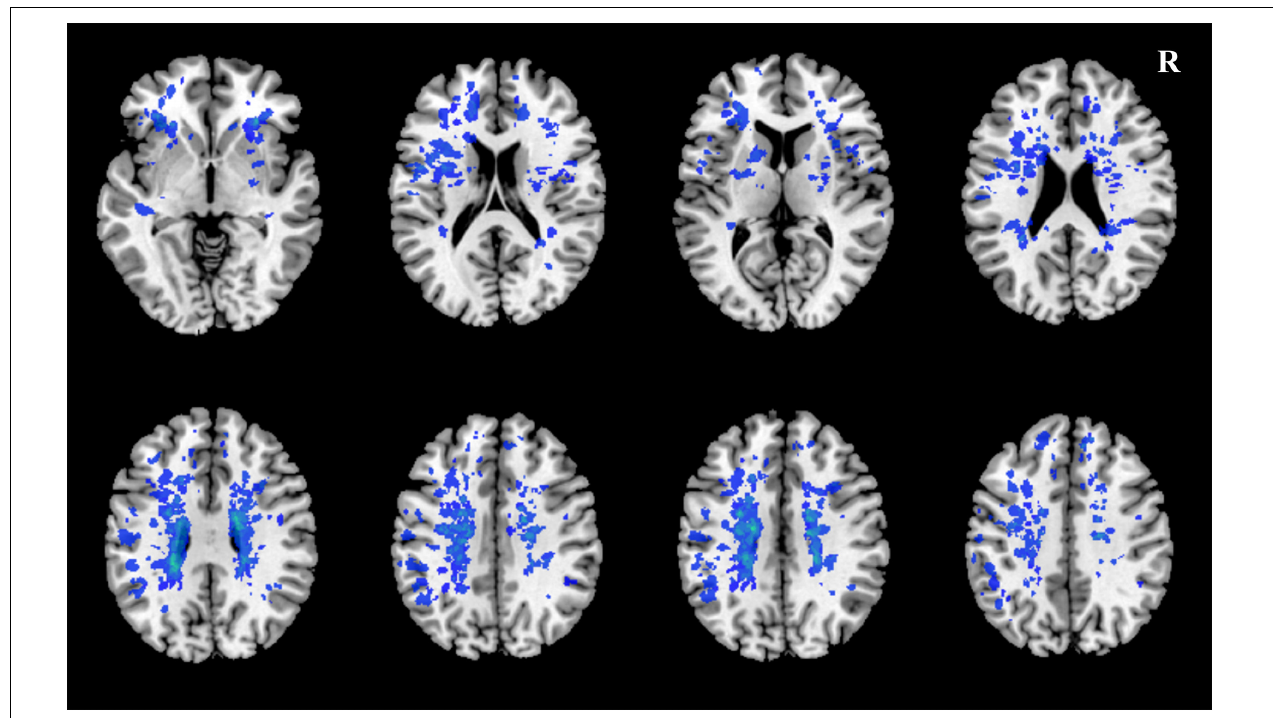
FIGURE 5 | The distribution of WMH lesions in all subjects. All WMH lesions ipsilateral to the ICAS side are shown in the left